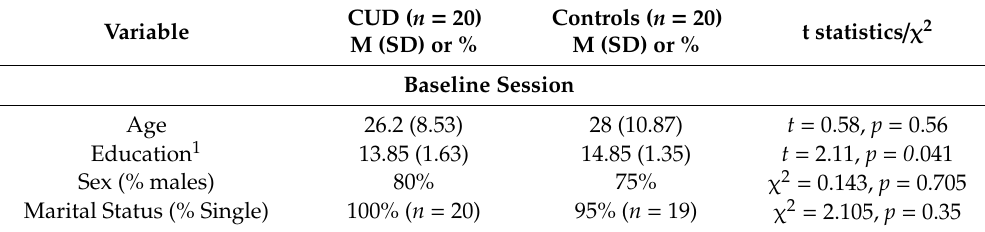
Table 1. Demographic